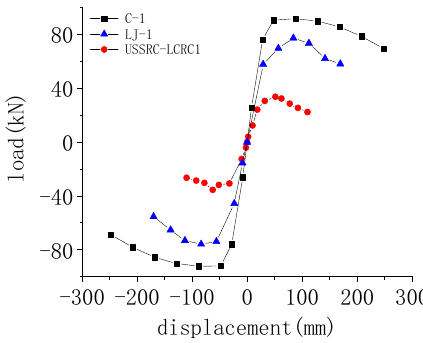
Figure 14. Comparison of the skeleton curves of the three types of components.